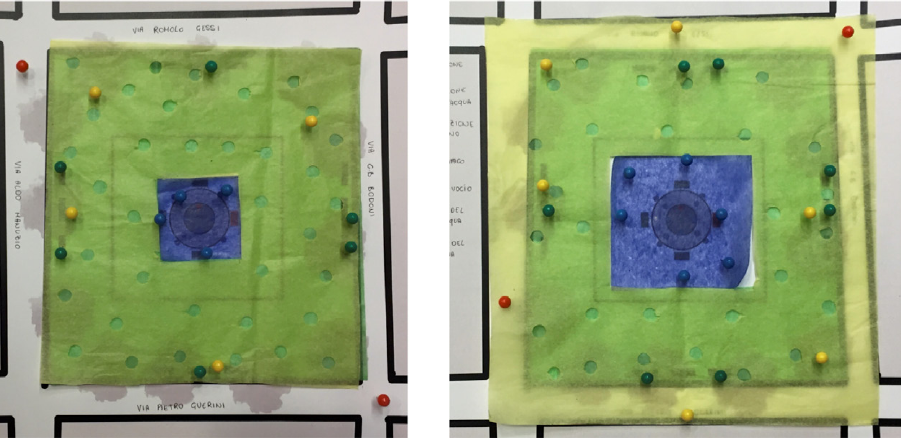
Figure 4: Visualization of the sound perception in Piazza Testaccio. 11.30 p.m. Colors Legend as in Figure 1B ( A ) blindfolded. ( B ) open-eyed. To be noticed: as the day unfolds into night, the yellow tissue gains more and more space, indicating a feeble but recognizable sound of the fountain gains more and more